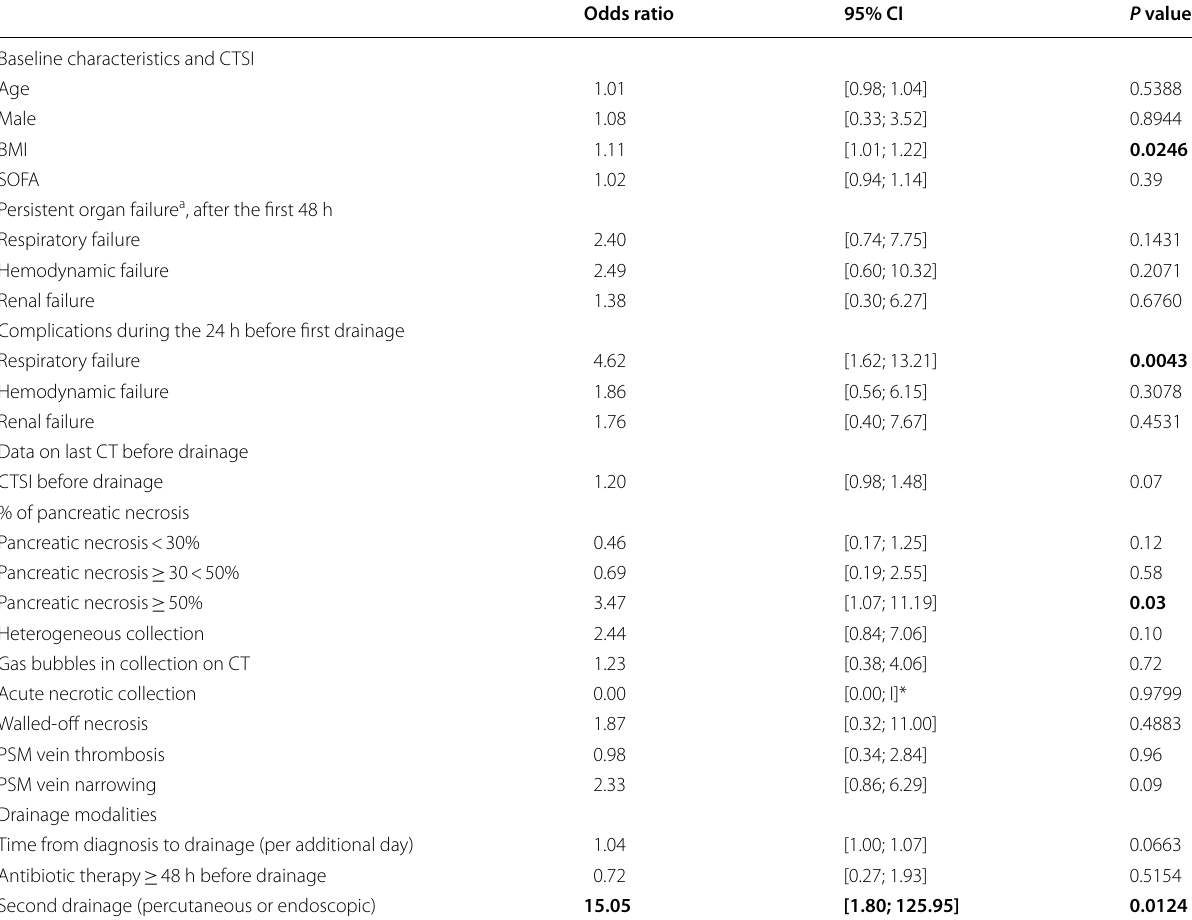
Table 2 Univariate regression analysis to identify predictors of catheter-drainage failure